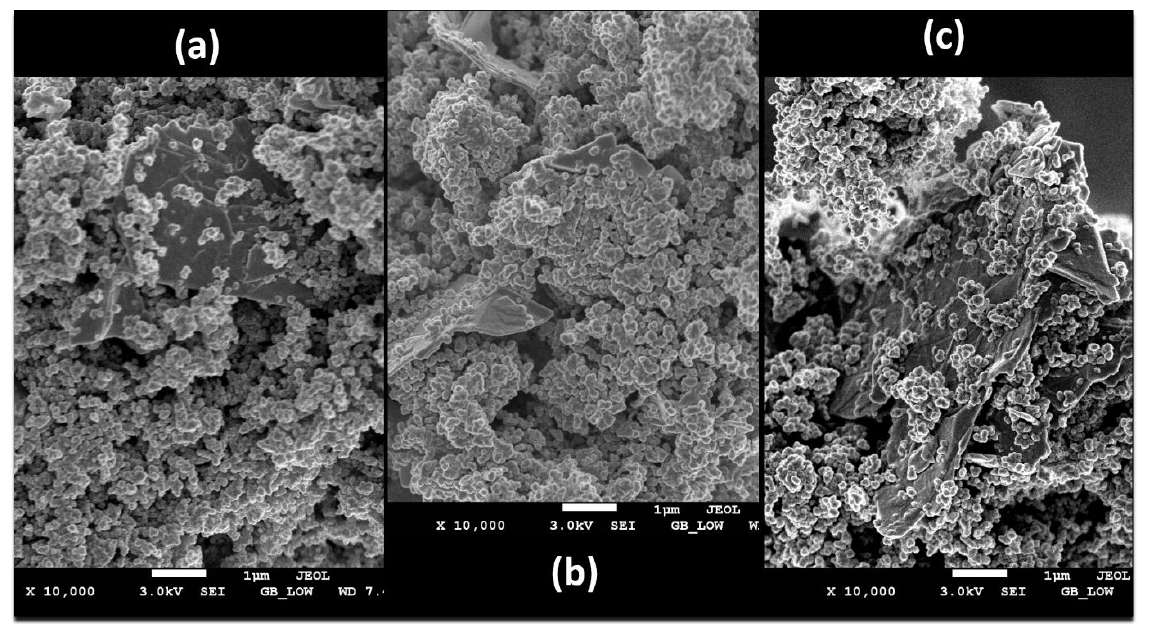
Figure 3. SEM graphs of ( a ) HGPPy.CB 20% 1:3 ( b ) HGPPy. CB 20% 3:7 ( c ) HGPPy.CB 20%